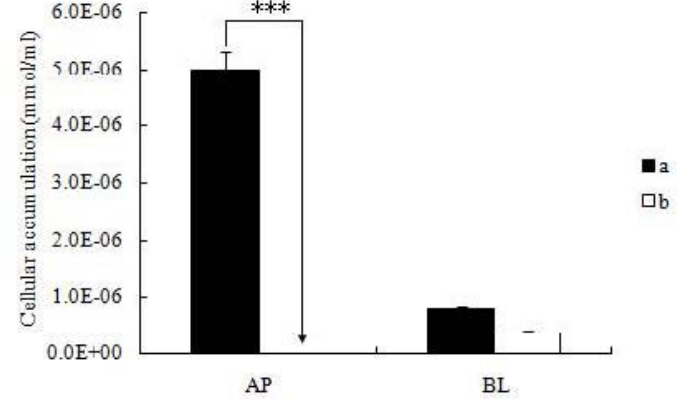
Figure 5. The cellular accumulation of the icariin + DOC and icariin + DOC + suet oil. The accumulation was measured after 4 h incubation of cell monolayers with the icariin + DOC and icariin + DOC + suet oil. Each data point is the average of three determinations, and the error bars represent the standard deviation of the mean. One-way ANOVA with Tamhane’s post hoc test was used to analyze the data statistically, *** p < 0.001. ( a : 20 μ M icariin + DOC; b : 20 μ M icariin + DOC + suet